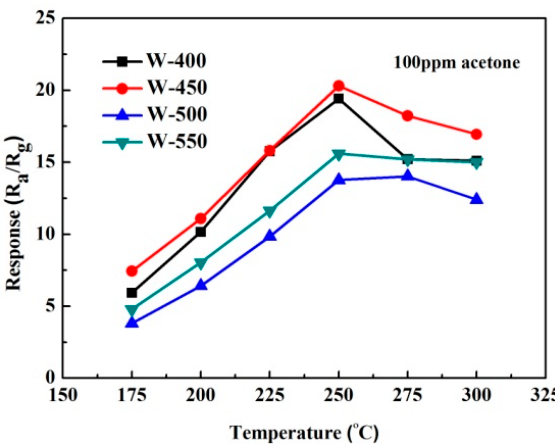
Figure 7. The responses of W-400, W-450, W-500 and W-550 gas sensors as a function of the operating temperature to 100 ppm acetone.